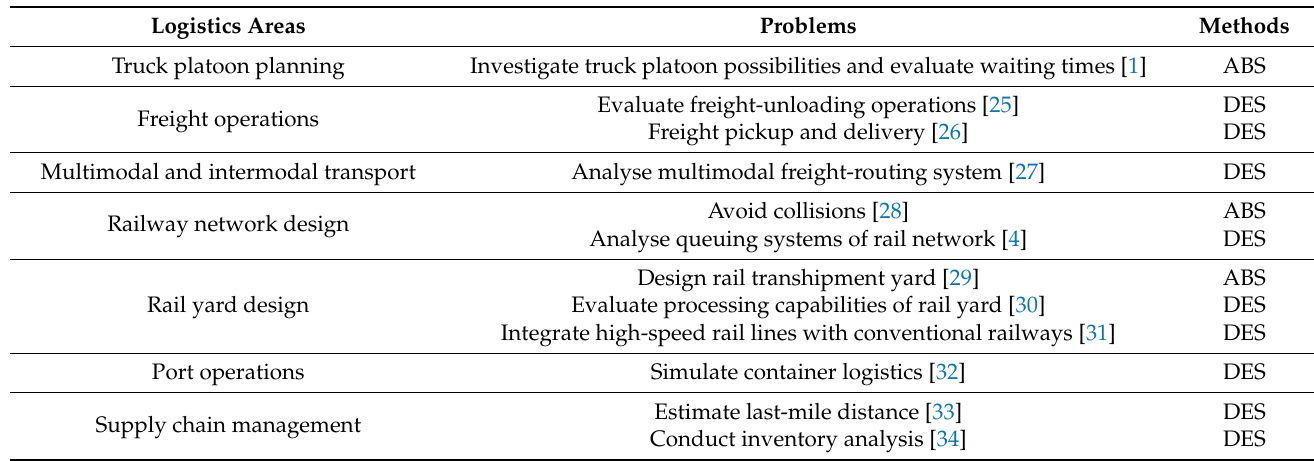
Table 1. Applications of ABS and DES on